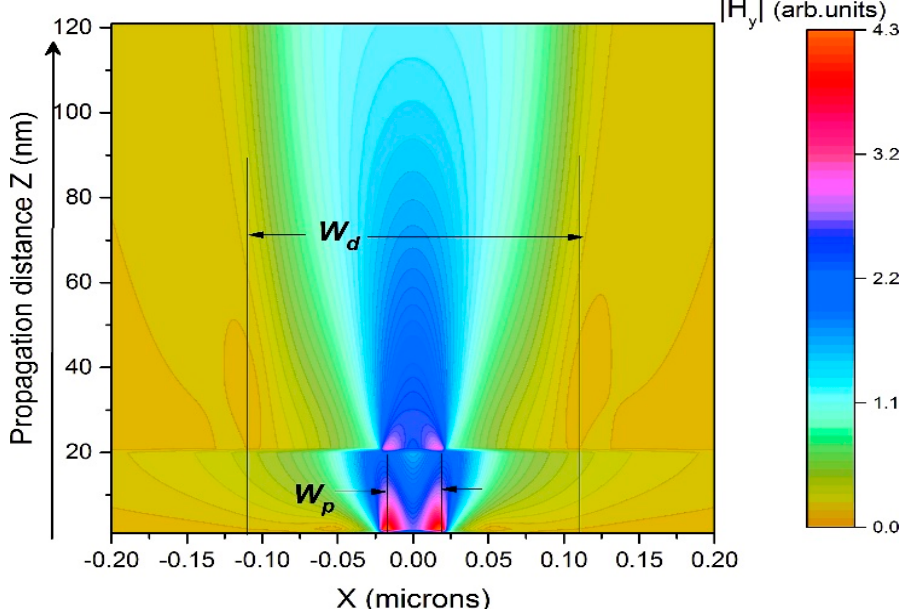
Figure 7. The confined TM 0 mode of the plasmonic guide expands inside the silicon core of width W d , where the symmetric TM 0 mode is well established after almost 100 nm.